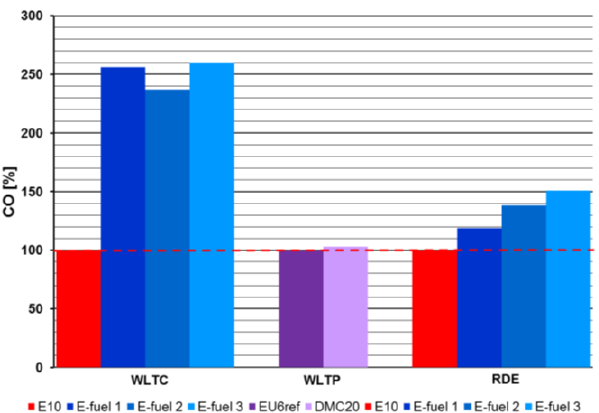
Fig. 3. Changes in the mean CO exhaust emissions for various synthetic fuels compared to conventional petroleum fuels measured in the